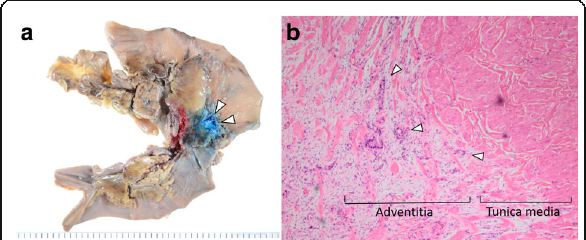
Fig. 3 Macroscopic and microscopic findings of resected specimen of case 1. a Inferior vena cava (IVC) wall was resected together with the pancreatic head ( arrowhead ). b Tumor invasion of the adventitia of the IVC wall was observed ( arrowhead ) (hematoxylin and eosin stain, ×40)